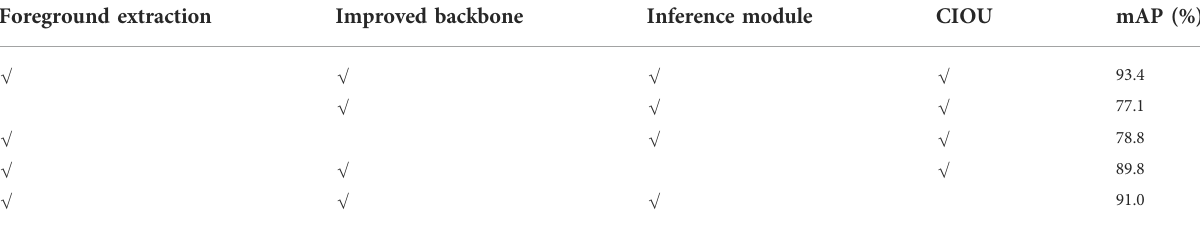
TABLE 4 Results of ablation